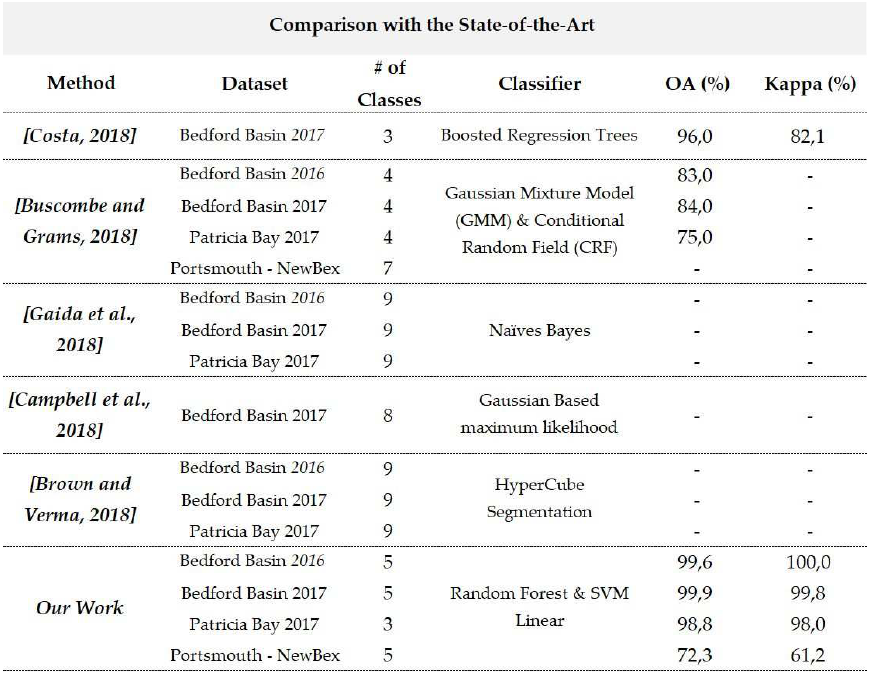
Table 5: Comparing our results with the